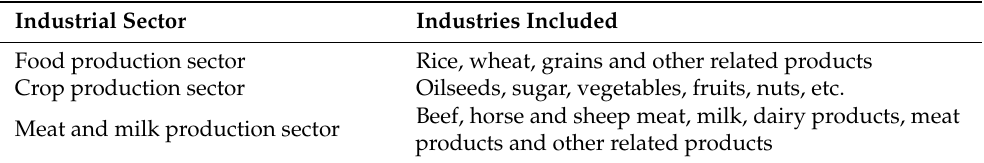
Table 2. Agricultural industry sector